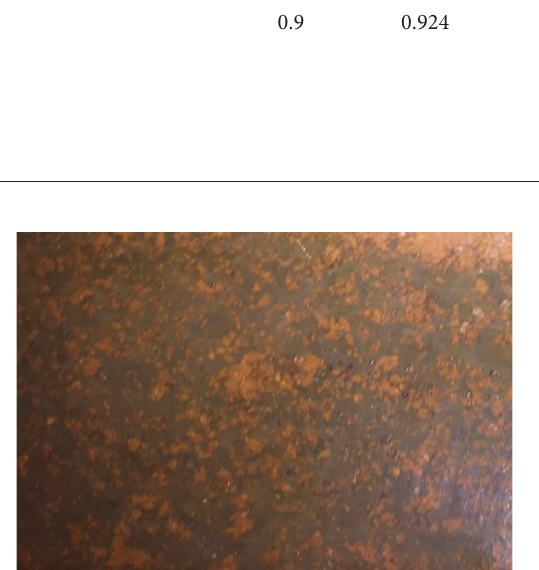
Figure 9: Sand layer penetration